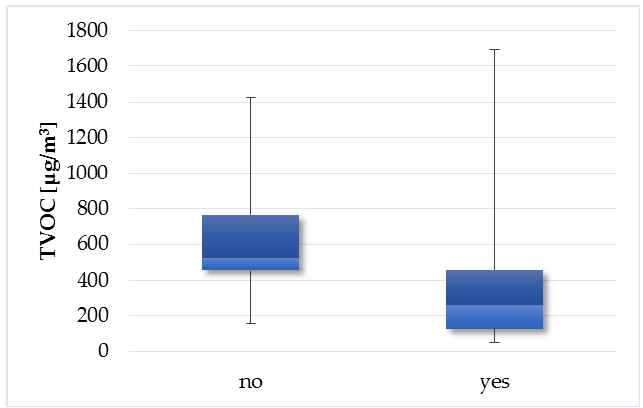
Figure 15. Boxplot of total medians—windows opening during cleaning activities.